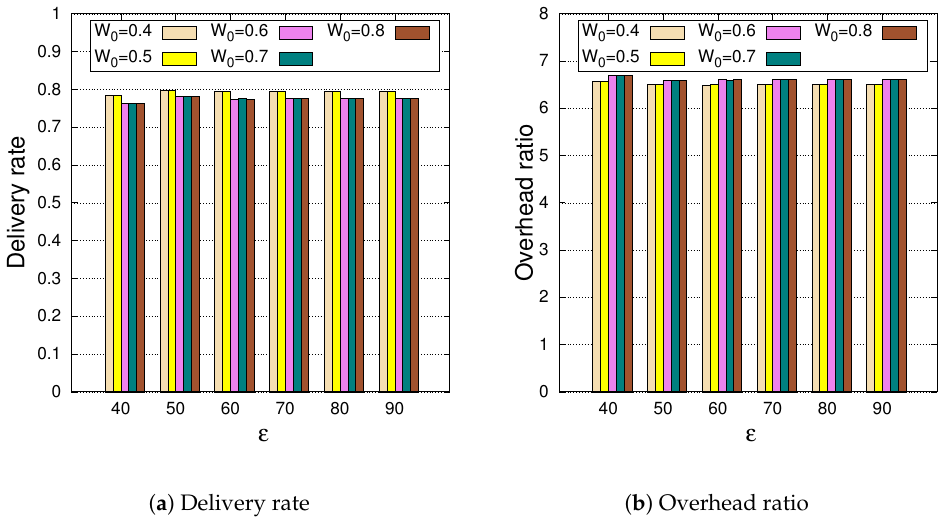
Figure 4. Results by MPMF with different values of (cid:101) and W 0 under NCCU trace (TTL = 5 h and buffer size = 10 MB).